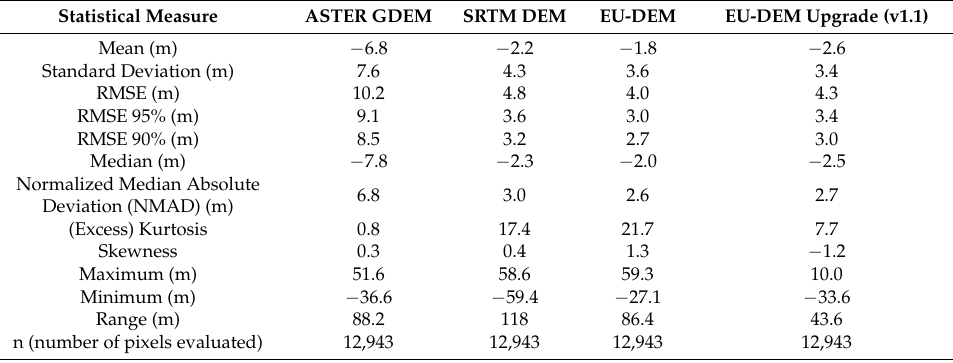
Figure 5. Histogram of absolute elevation errors for the EU-DEM upgrade (v1.1). Table 1. Absolute elevation errors: descriptive and other statistics for the three evaluated DEMs. EU-DEM performs significantly better in most of the statistical parameters evaluated.